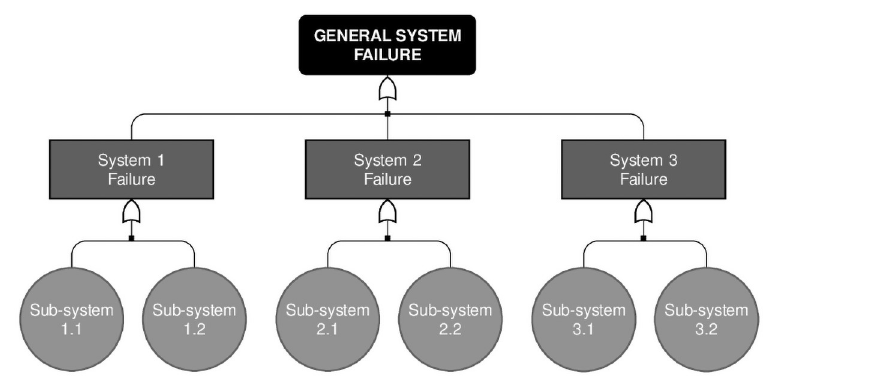
Fig 4. Proposed failure structure. Simulated failure structure for Scenarios 1, 2 and 3.